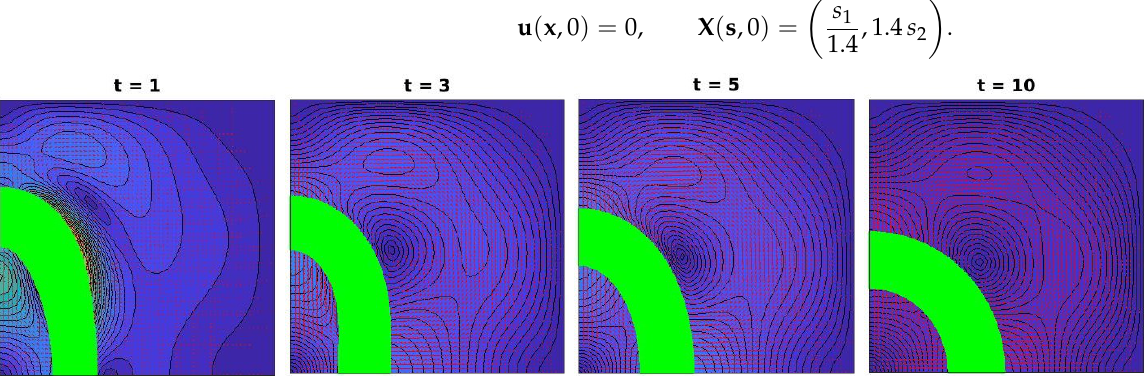
Figure 1. Four snapshots of the evolution of the structure with linear constitutive law.